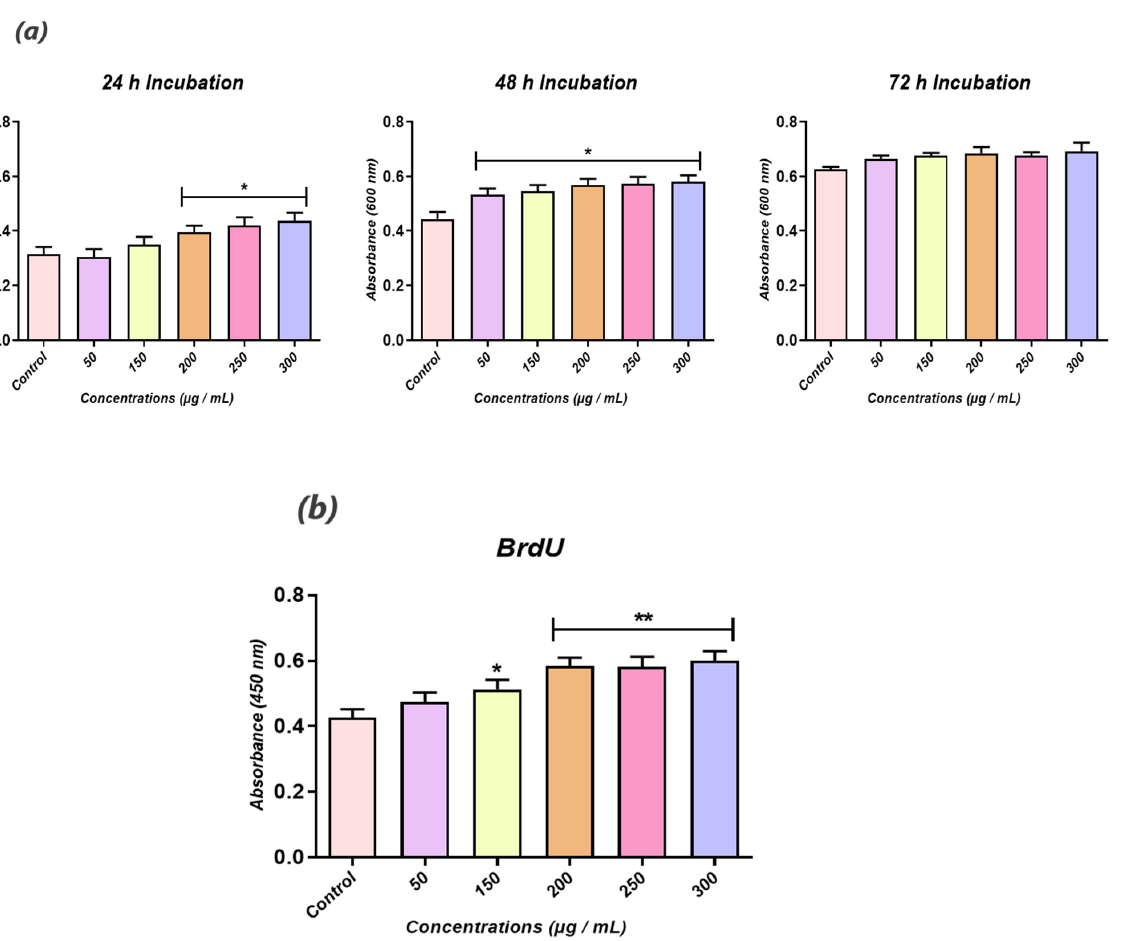
Figure 2. Biocompatibility assessment of total calystegines extract on HuASCs cells. ( a ) Histograms depicting the average absorbance at 600 nm of the metabolised Resazurin dye. ( b ) Average absorbances of incorporated BrdU into newly synthesised DNA of treated HuASCs cells. Representative data from three independent experiments are shown ± SD (n = 3). An asterisk (*) indicates a comparison of treated groups to untreated healthy cells. * p < 0.05, ** p < 0.01.